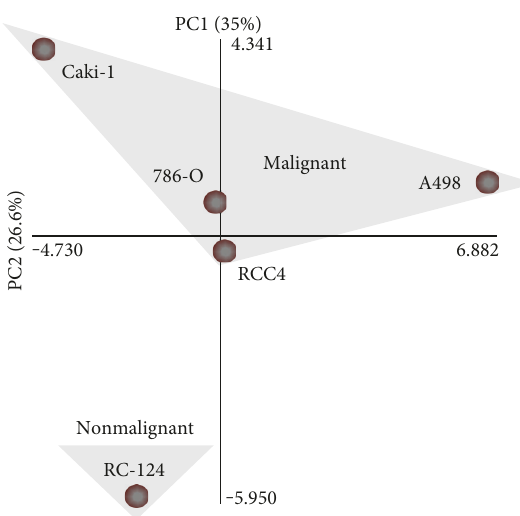
Figure 3: Principal component analysis (PCA) of the cytokine and chemokine expression. The RCC cell lines Caki-1, 786-O, RCC4, and A498 as well as the nonmalignant renal cell line RC-124 were plotted in a two-dimensional coordinate plane de fi ned by the principal components 1 (PC1) and 2 (PC2) analyzing the expression data of all cytokines and chemokines measured by the DNA array (Human Cytokines & Chemokines RT 2 Pro fi ler PCR Array; Qiagen). Clustering of the malignant cells is indicated by a grey